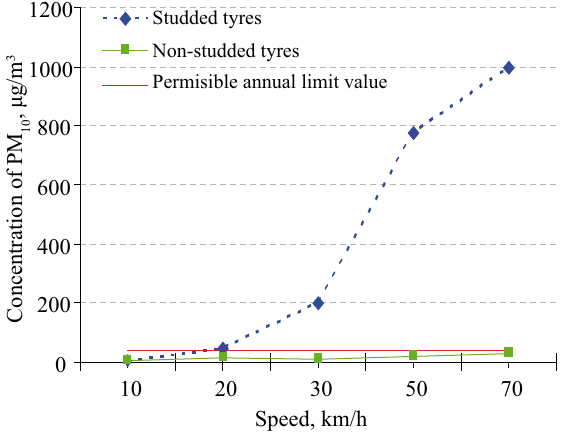
Fig. 2. Dependency of PM 10 emissions on the speed of vehicles with and without studded tyres by Kupiainen